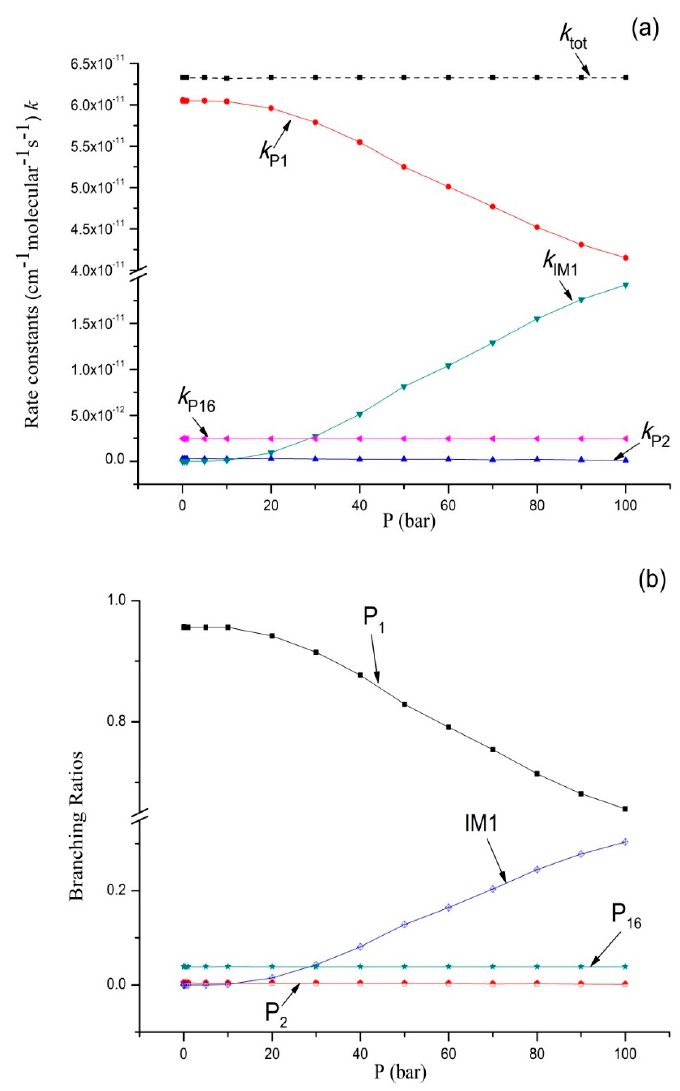
Figure 3. ( a ) Rate constants of total and various reaction channels at 293 K in a pressure range from 1× 10 − 4 bar to 100 bar; ( b ) Branching ratios of various reaction channels at 293 K in a pressure range from 1× 10 − 4 bar to 100 bar.